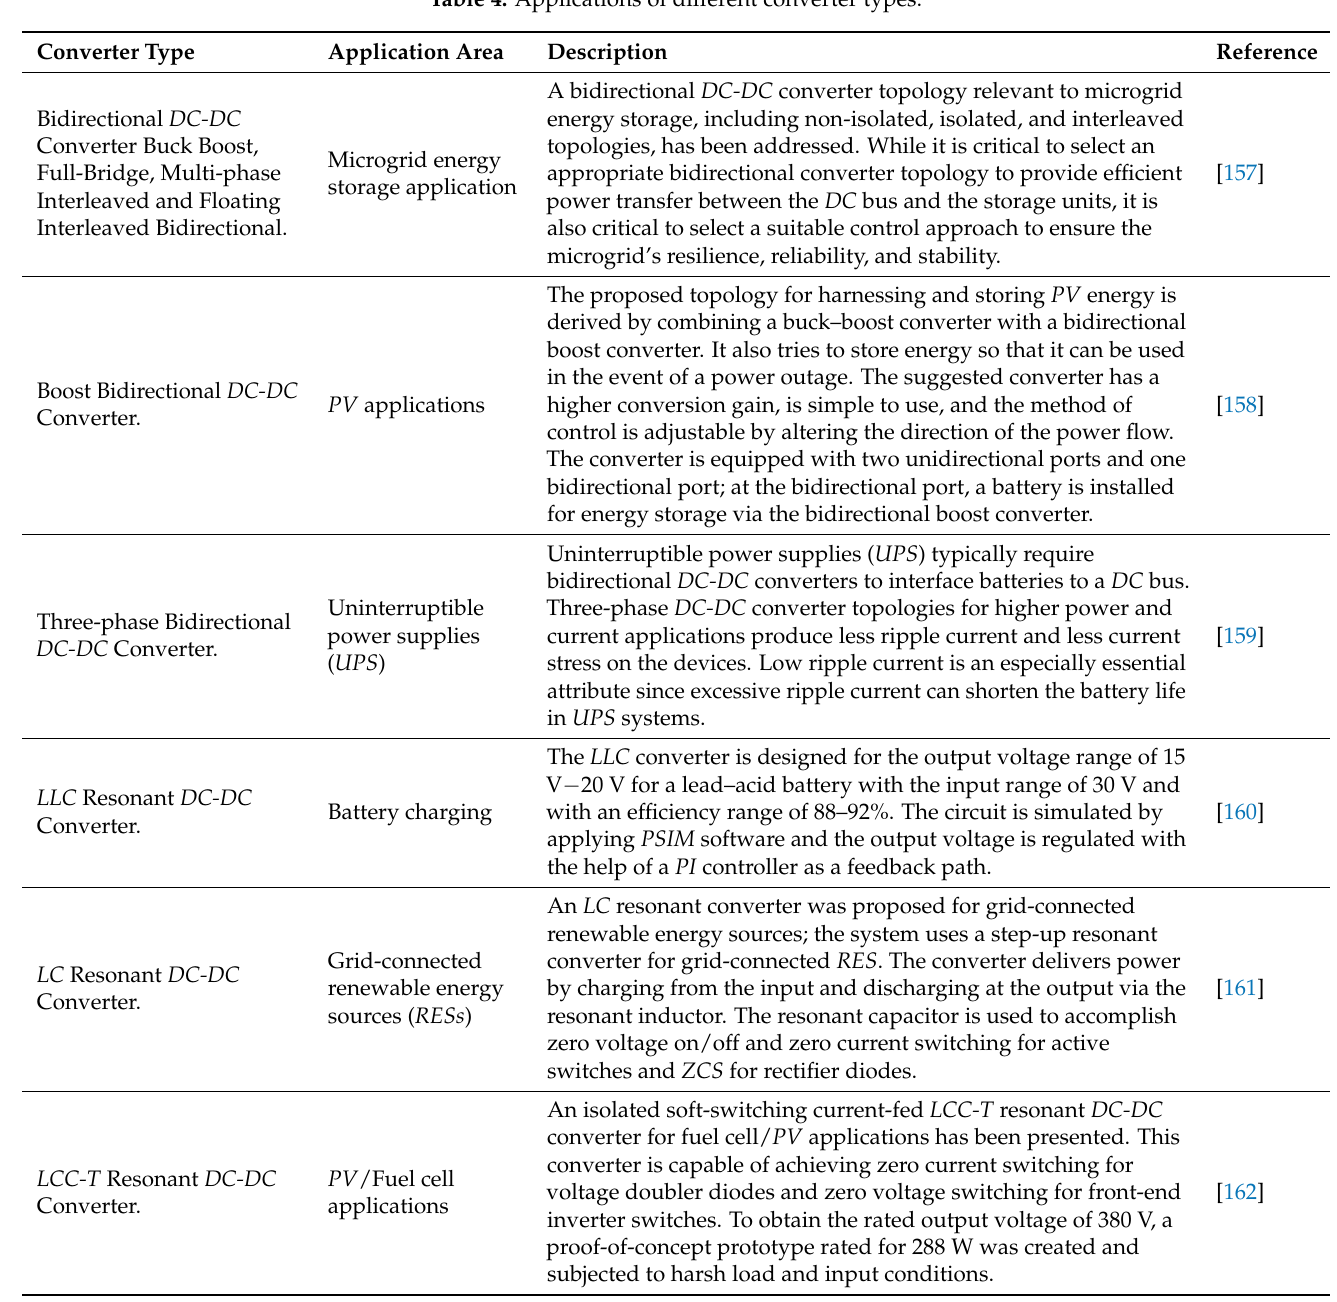
Table 4. Applications of different converter